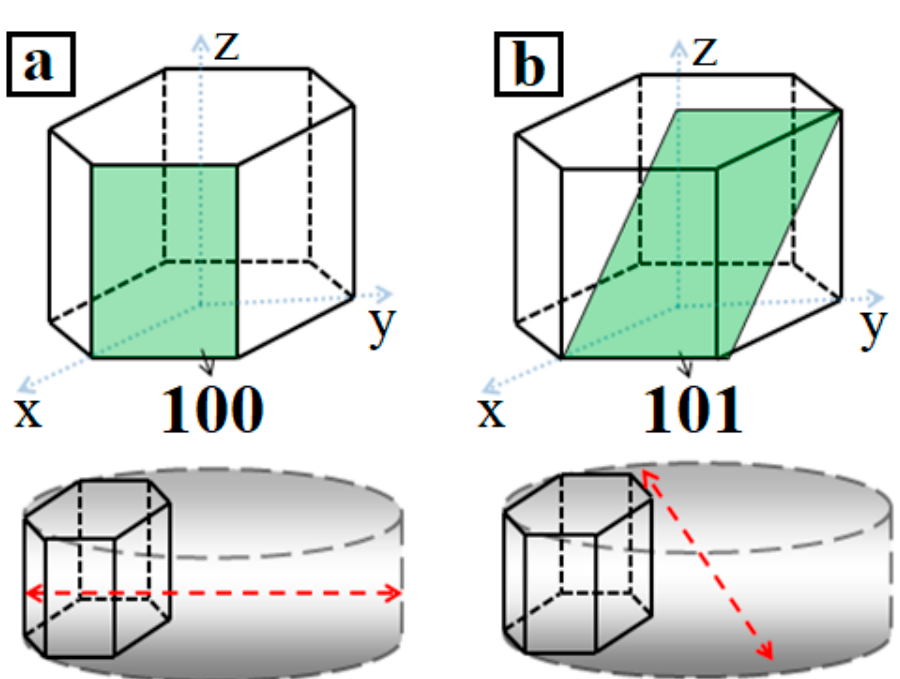
Figure 7. Coherent scattering region (CSR) sizes for the (100) ( a ) and (101) ( b ) planes.